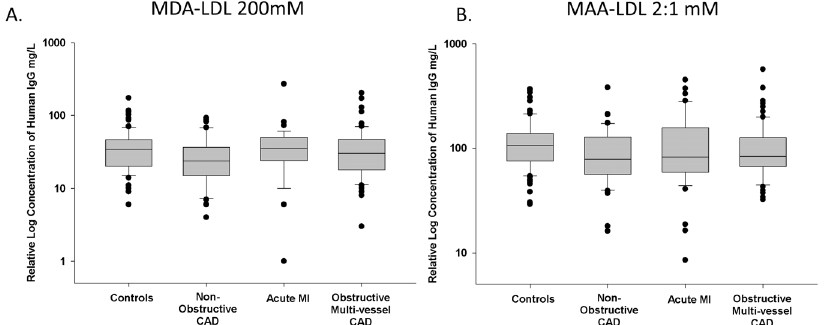
Figure 2. Relative Serum Concentrations of anti-MDA LDL and anti-MAA LDL IgG Antibody are not Different in Individuals with Coronary Artery Disease (CAD) and in Individuals who Present with an Acute Myocardial Infarction (AMI). CAD patients were grouped in the following categories; control patients (n=82), patients with chest pain and CAD (Non-Obstructive CAD, n=40), patients presenting with AMI (n=42), and patients with significant Multi-Vessel Obstructive CAD requiring coronary bypass grafting (n=72). Serum anti-MDA LDL (Figure 2A) and anti-MAA LDL (Figure 2B). There is no significant difference in serum antibody levels when comparing all study groups (p . 0.5).